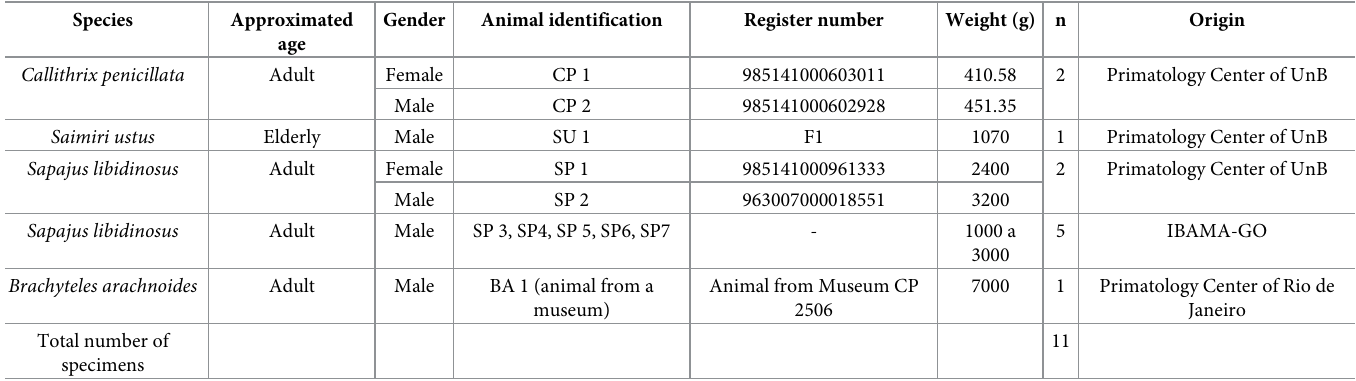
Table 9. General data of study